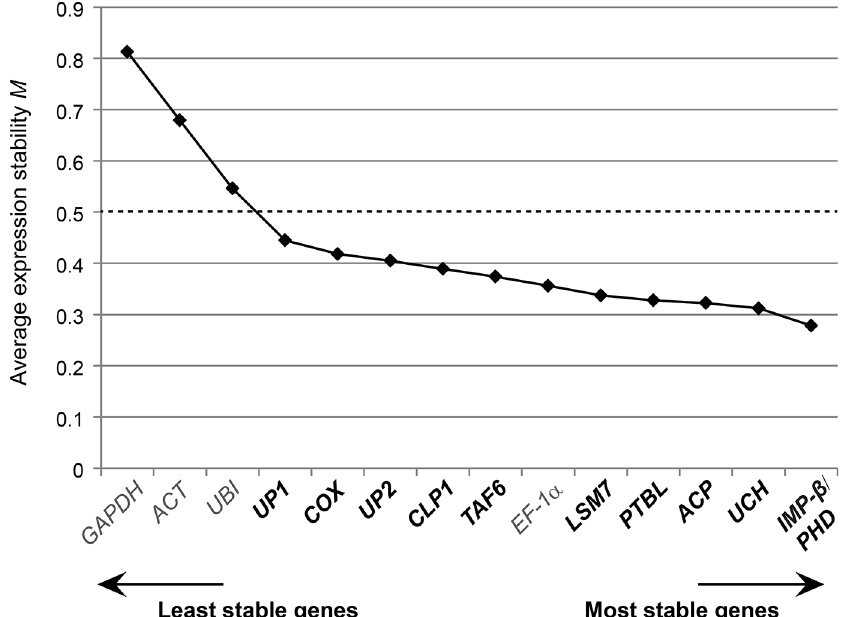
Fig 3. Expression stability of candidate reference genes in Xcv -infected and mock-treated tomato plants evaluated by geNorm. Tomato reference genes were ranked based on expression stability calculated by geNorm. New reference gene candidates are indicated in bold. M values represent the average expression stability of each gene (n = 48). The cut-off value for reliable reference genes is indicated by a dashed